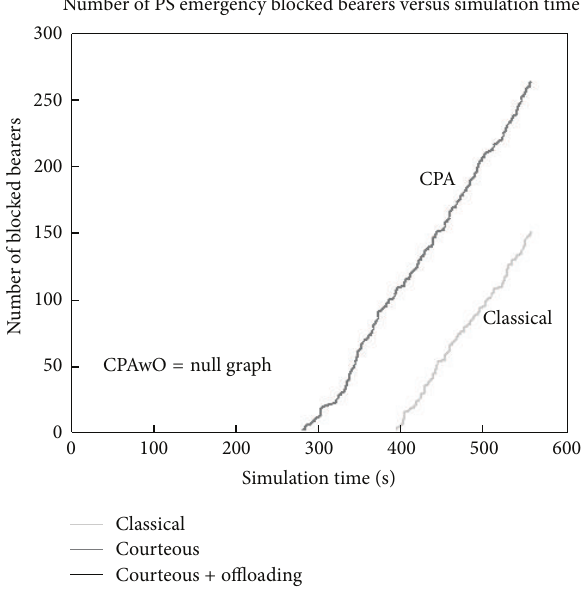
Figure 9: Number of PS emergency blocked bearers.